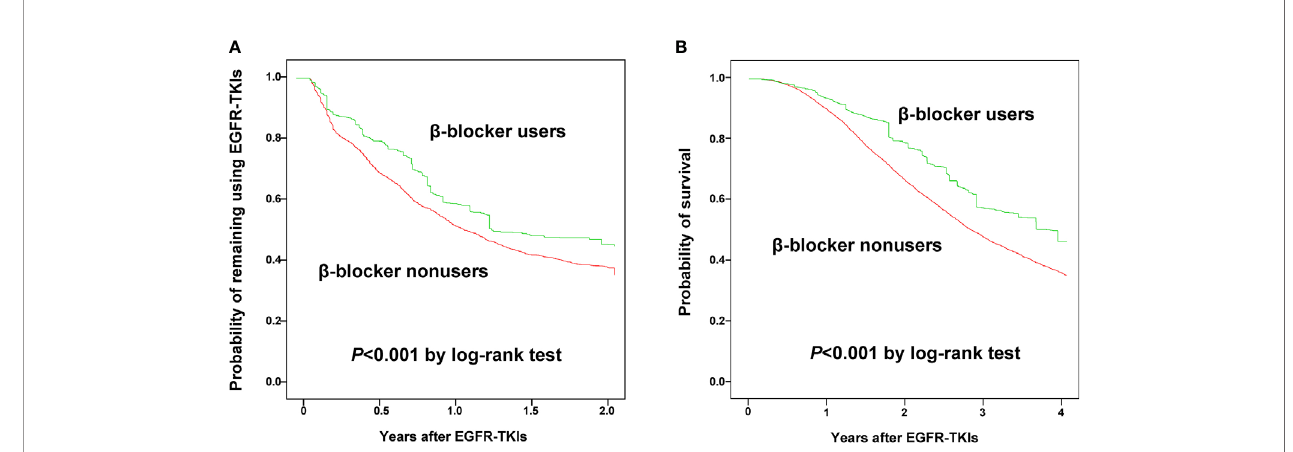
FIGURE 2 | Kaplan-Meier curves for time to discontinuation of epidermal growth factor receptor-tyrosine kinase inhibitors within 2 years (A) and 4-year overall survival (B) between b -blocker users and nonusers.